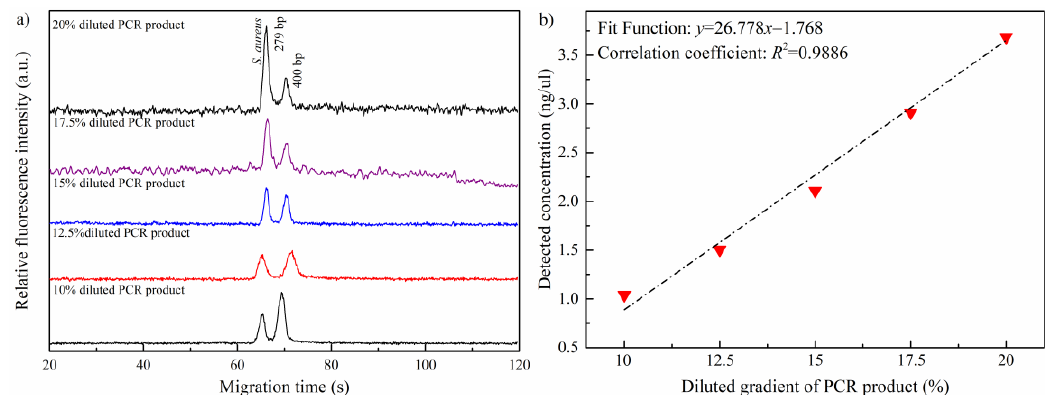
Figure 4. ( a ) Electrophoretograms for PCR products of nuc gene in different concentrations; ( b ) the relationship between the detected concentration and the diluted concentration of the PCR products. The electrophoretic conditions were the same as that of in Figure 3. Table 1. Detected concentrations of gradient PCR products of the nuc gene.